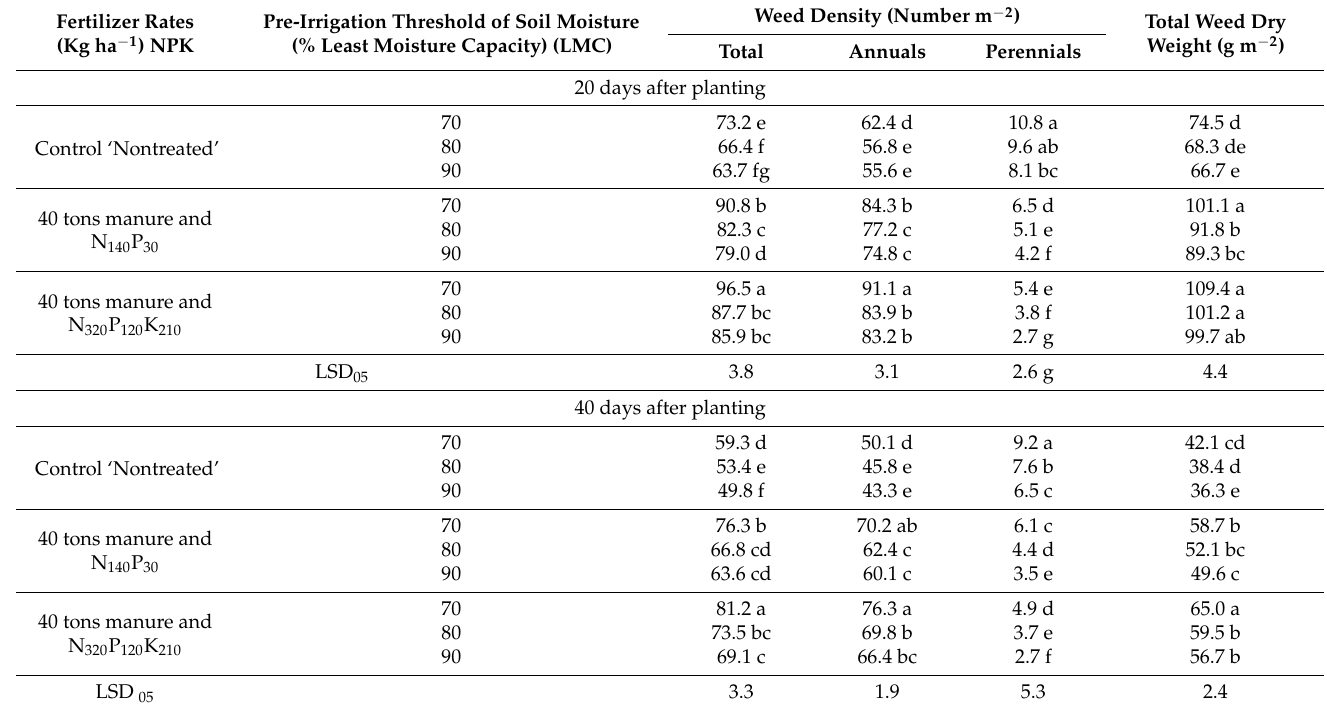
Table 1. The number of weeds in the eggplant crop depending on the rates of mineral fertilizers and the levels of pre-irrigation moisture of the